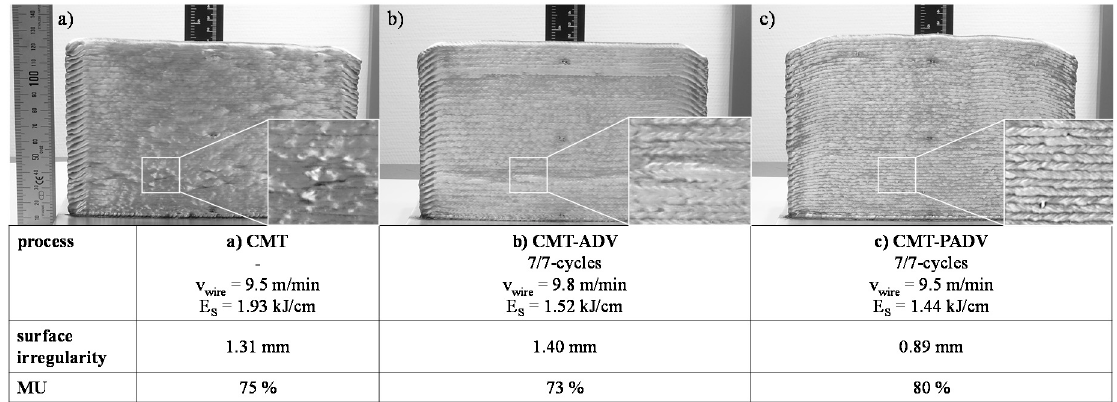
Figure 11. Side view of the multilayer walls made of AlMg5Mn, which were additively manufactured ( a ) by CMT with 62 layers, ( b ) by CMT-ADV with 56 layers and ( c ) by CMT-PADV with 56 layers and the information to the surface irregularity and material utilization